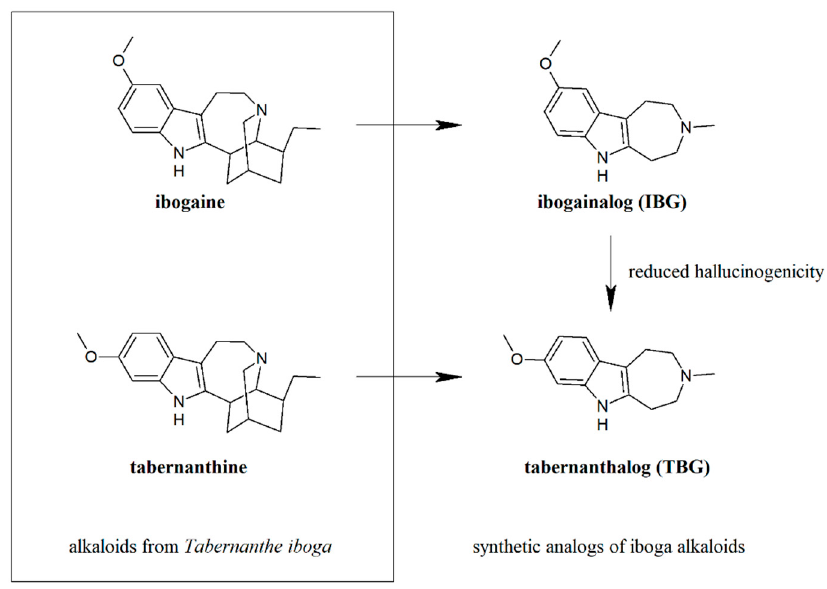
Figure 2. Synthetic 5-HT 2A agonists and their precursors of natural origin.